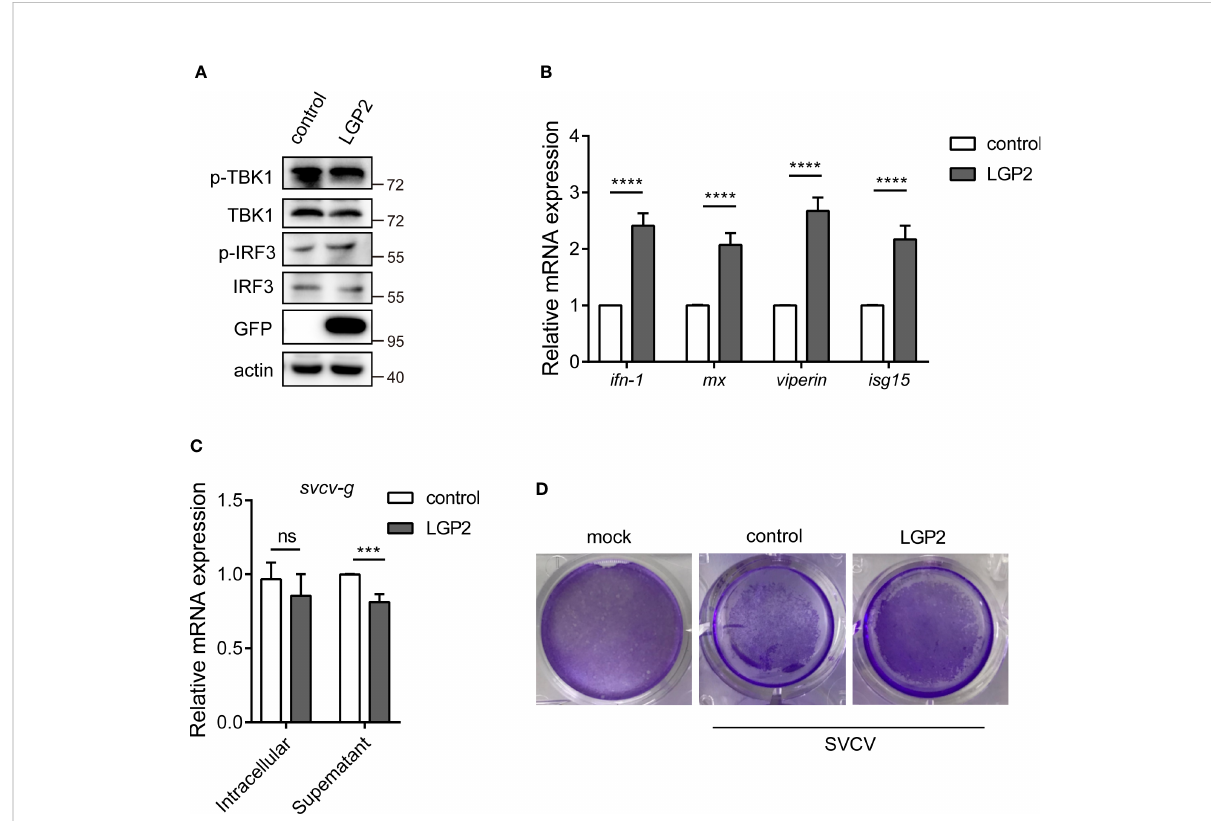
FIGURE 5 Cc LGP2 enhances the IFN activity and inhibits viral replication. Empty vector or GFP-tagged Cc LGP2 plasmid were transfected into EPC cells for 24 h. Further, the protein and RNA were extracted to detect downstream signaling molecules by Western blot (A) and qPCR (B) . (C, D) EPC